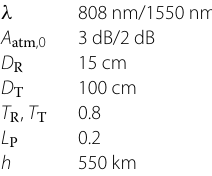
Table 2 Link attenuation